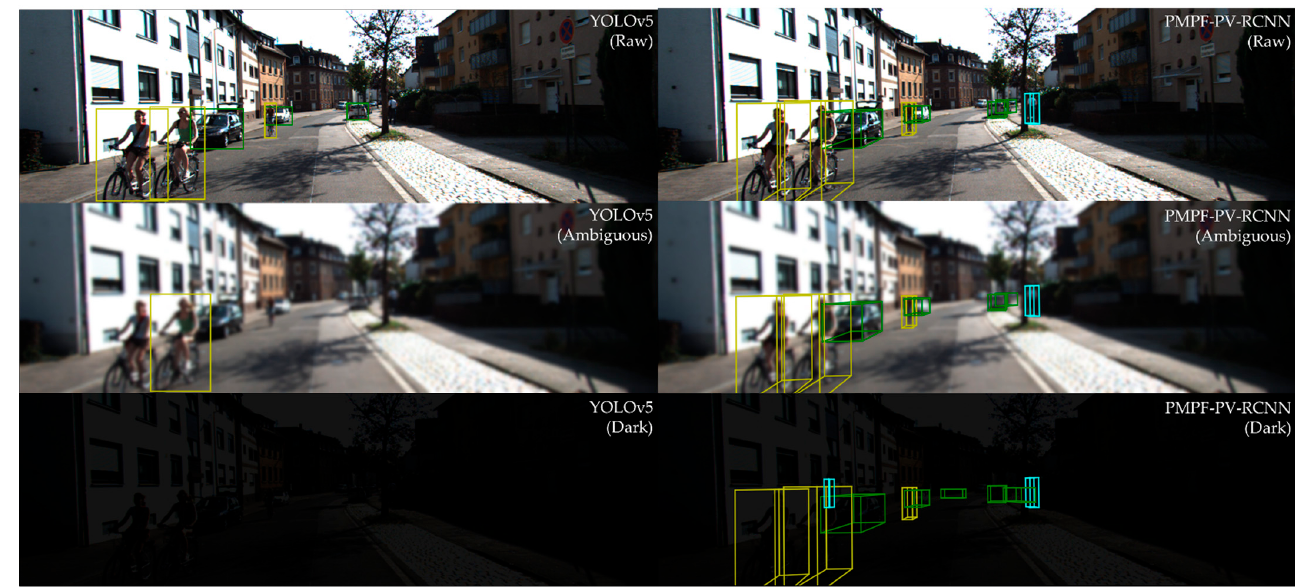
Figure 7. Qualitative comparison between PMPF and YOLOv5 [52] under different image quality scenarios on the KITTI 3D object detection dataset. The figures are marked in the same way in Figure 5.